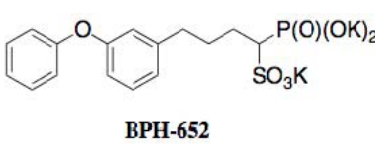
Figure 13. Structure of